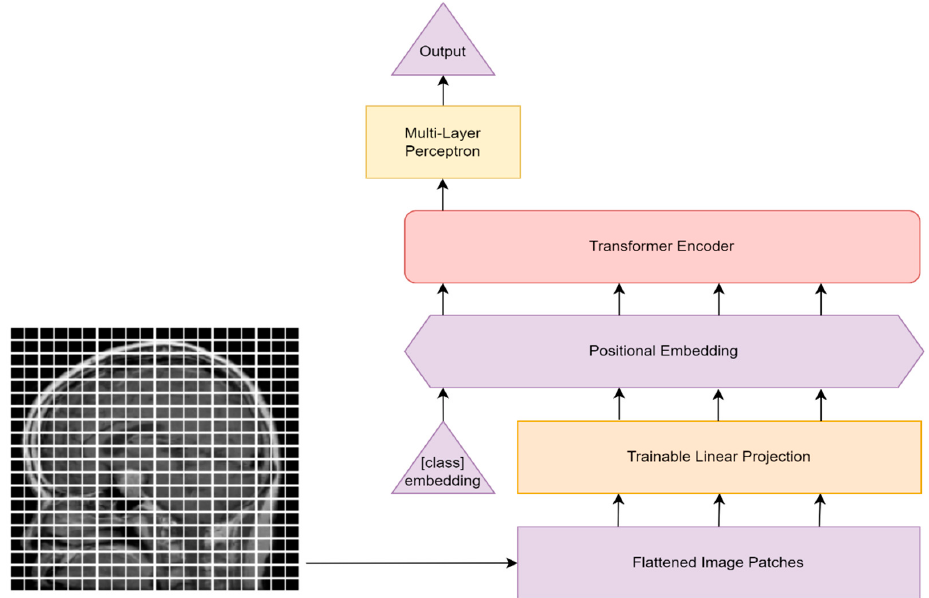
Figure 4. The Vision Transformer architecture.